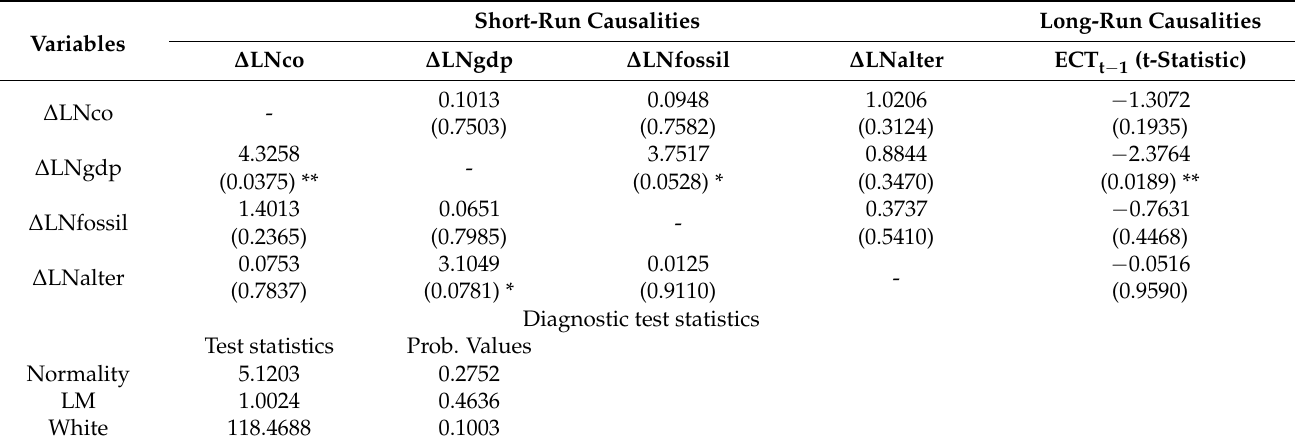
Table 7. Results of VECM Granger causality